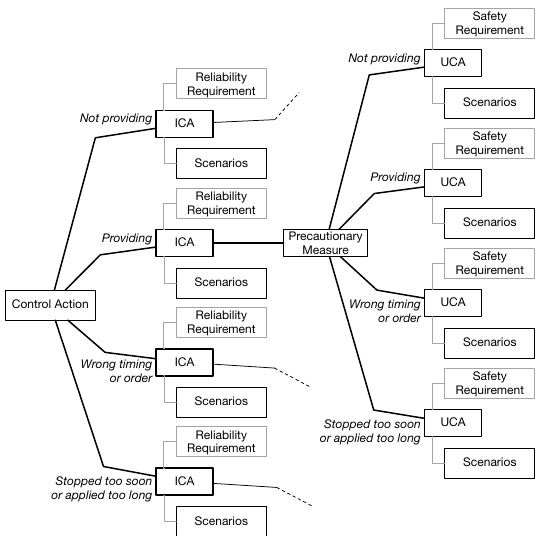
Figure 5. Documenting the analytical results by the Landscape Genealogical Layout Documentation (LGLD)